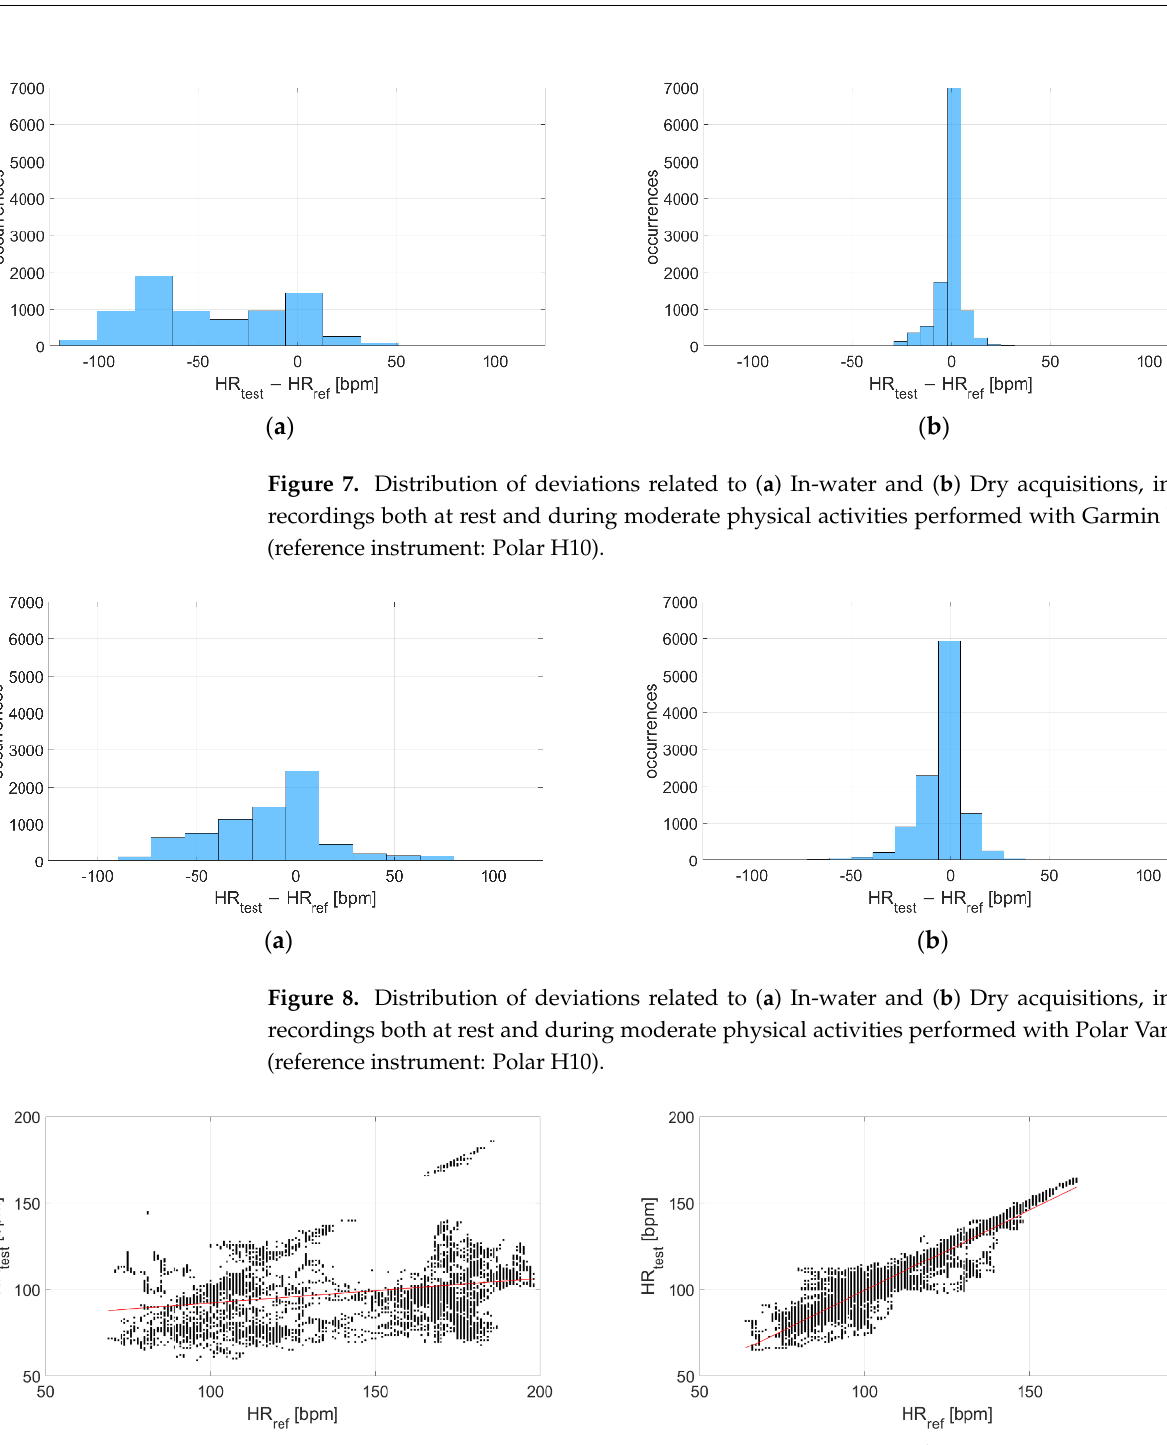
( b ) Figure 10. Correlation of measurements performed through Polar Vantage V2 with respect to the reference sensor (Polar H10) related to ( a ) In-water and ( b ) Dry acquisitions, including recordings both at rest and during moderate physical activities. Table 3. Metrological performance of the tested smartwatches in terms of measurement accuracy (µ) and precision (±2 σ ), confidence interval at 95% (CI95%), mean absolute percentage error (MAPE), and Pearson’s correlation coefficient ( ρ )—dry vs. in-water conditions. Testing Conditions 0.59 If measurement accuracy and precision are evaluated separately at rest and during activity (Table 4), it is possible to observe that accuracy is significantly worsened by the presence of water, as well as precision (both accuracy and confidence interval indicate wider ranges). Moreover, also MAPE increases for in-water tests. However, concerning activity, its effect is not so marked if in-water and dry tests are considered separately. In fact, for dry tests, the Pearson’s correlation coefficient seems better when recordings are made during activity. Instead, for in-water tests, activity degrades all the performance metrics. Consequently, it should be thoroughly considered that a worse performance is to be expected when smartwatches are employed for monitoring HR during in-water activ- ities.